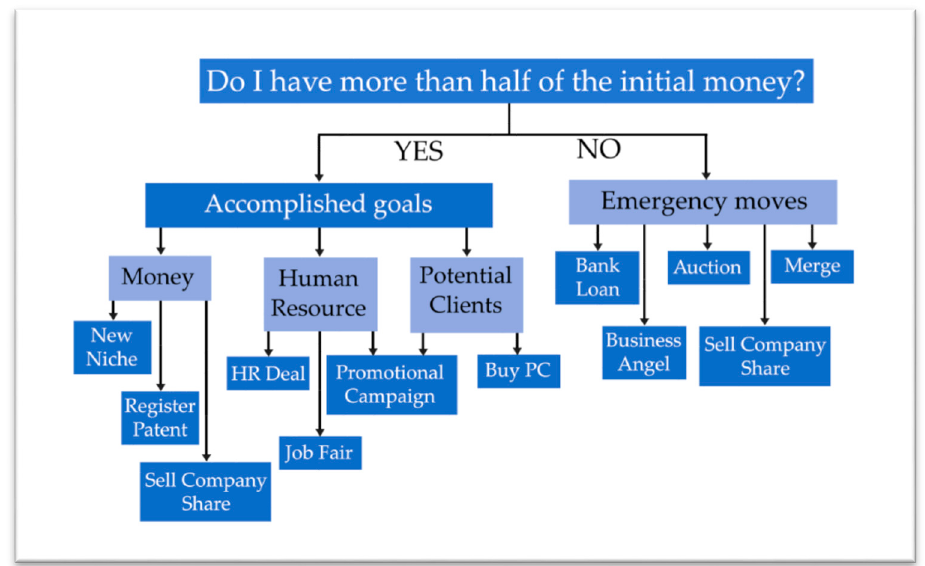
Figure 4. Strategic player’s decision tree.